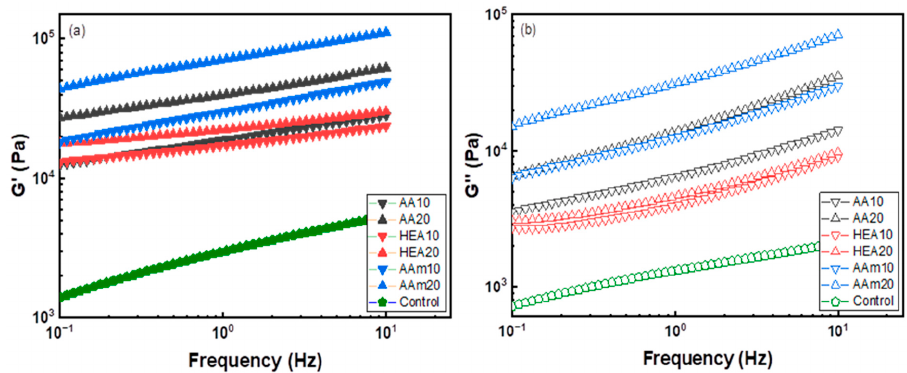
Figure 4. Storage ( a ) and loss modulus ( b ) of AMPS hydrogels modified with different comonomers.